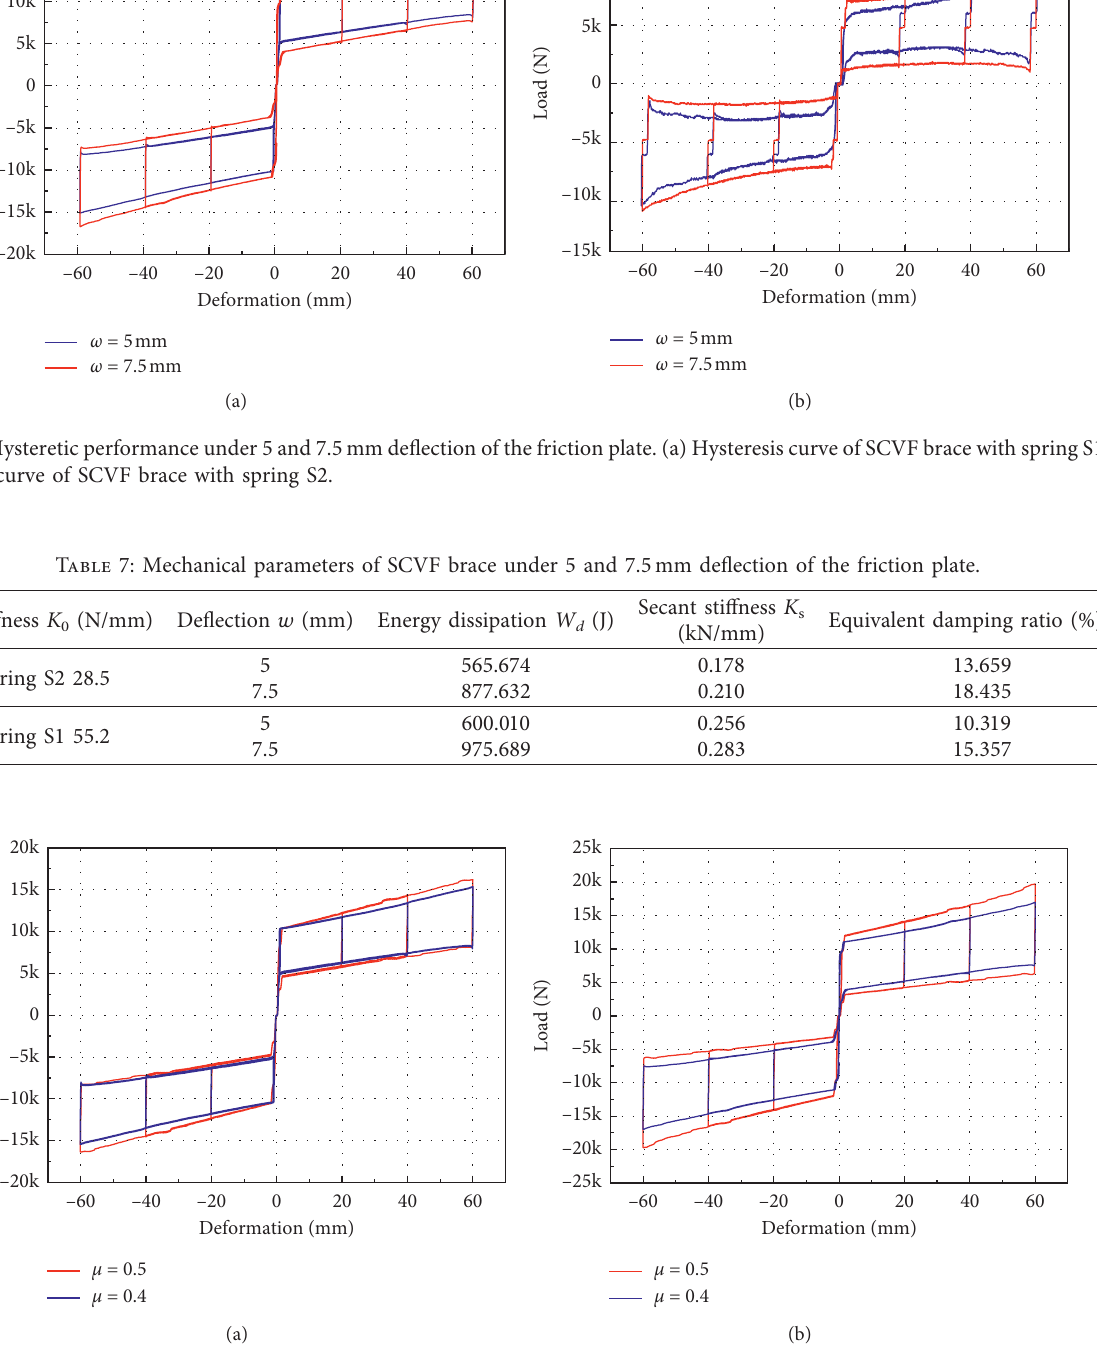
Figure 8: Hysteretic performance under different friction coefficients. (a) 5mm deflection of the friction plate. (b) 7.5mm deflection of the friction